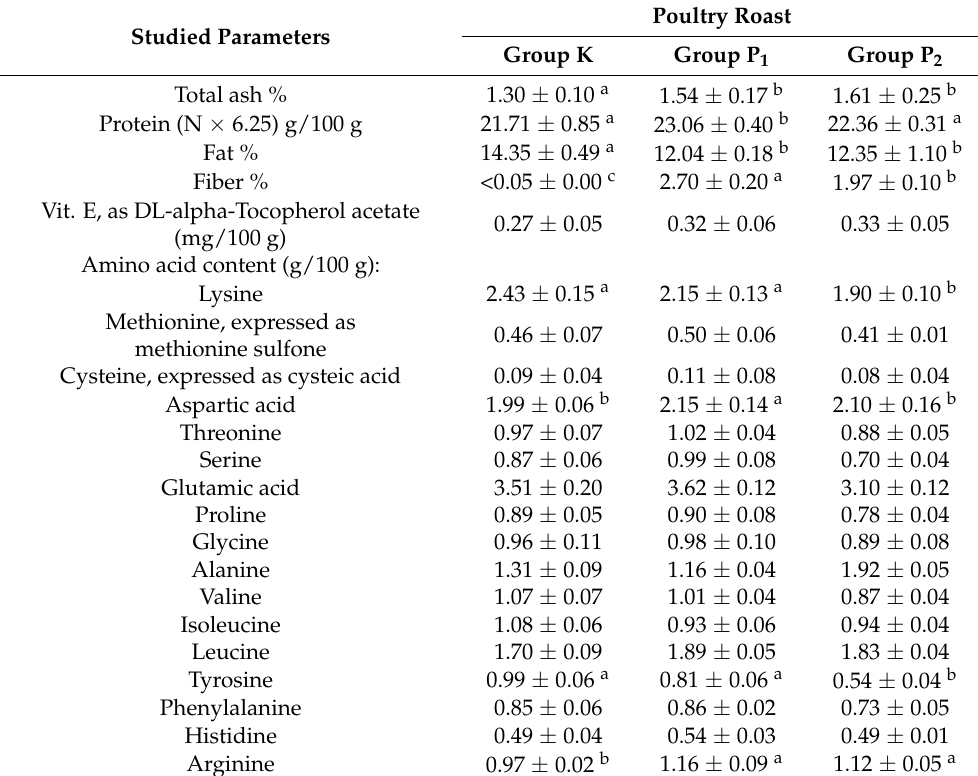
Table 3. Effect of enrichment with seeds, flour, and hemp oil on the basic chemical composition, fiber content, tocopherol, cholesterol, and amino acid profile of poultry roast (x ±